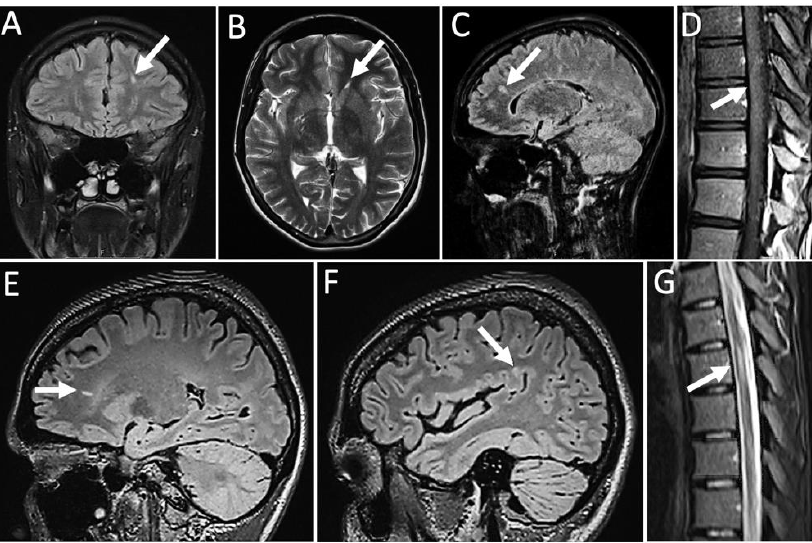
Figure 2. MR-imaging from 2013 ( A – D ) and 2021 ( E – G ), respectively. Sagittal ( C , E , F ) and coronar ( A ) FLAIR-sequences, horizontal T2w-sequence ( B ) and thoracolumbar sagittal sequences ( D , G ) with arrows indicating periventricular ( B , C , E ) and juxtacortical ( A , F ) lesions. Spinal lesions showing mild Gadolinium enhancement ( D ).